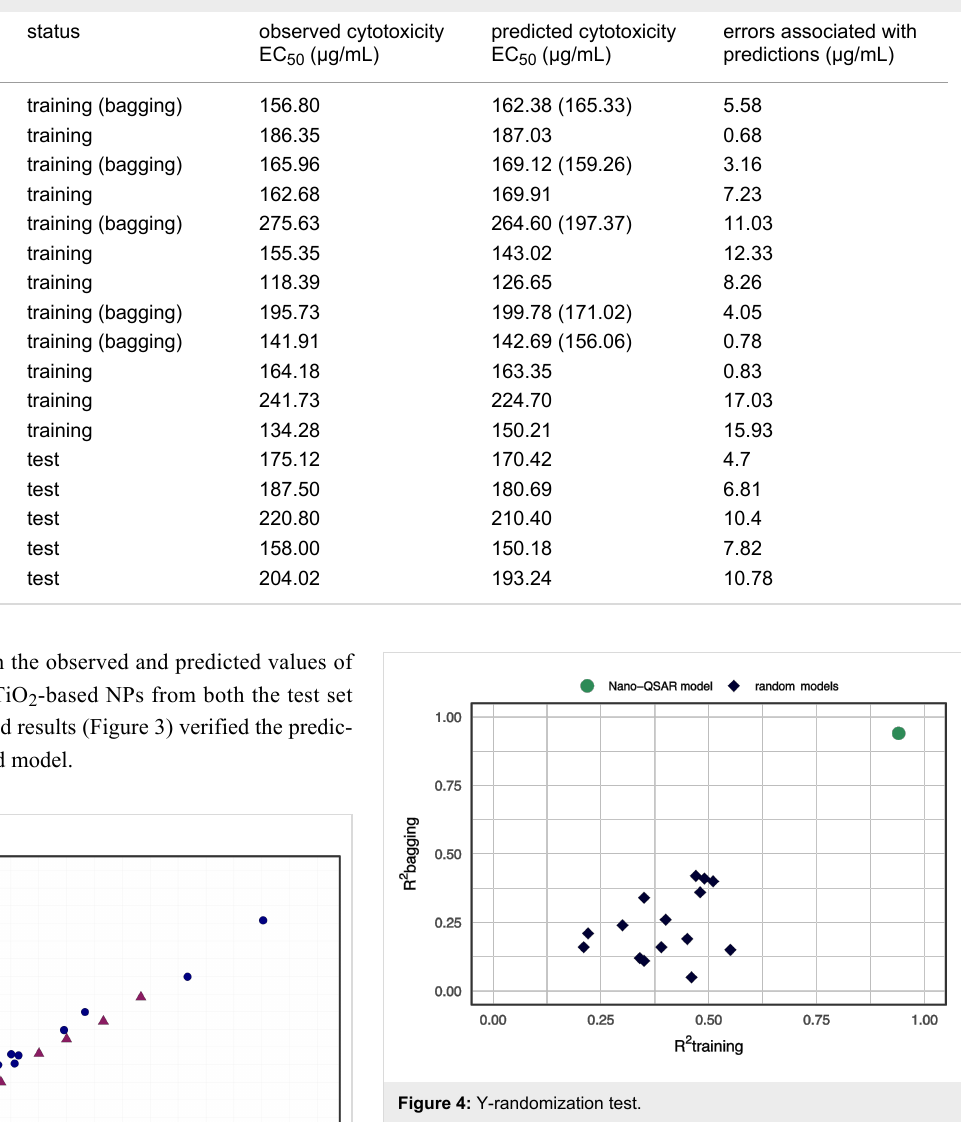
Table 3: Observed and predicted values for cytotoxicity of TiO 2 -based NPs.